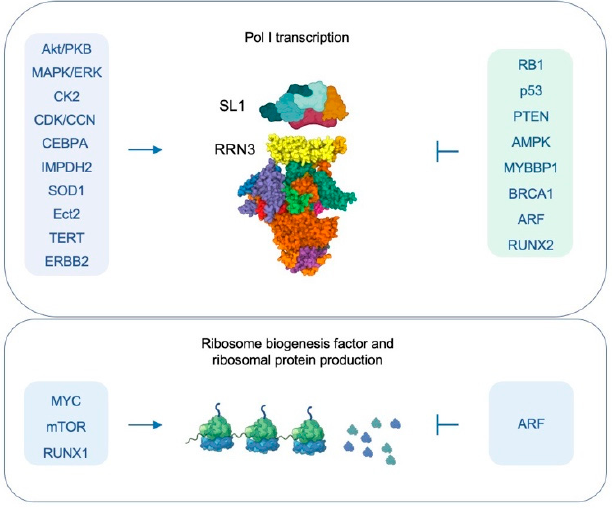
Figure 3. Major effects of positive and negative regulators of Pol I transcription and ribosome biogenesis in cancer. Human Pol I initiation complex depicted from Protein Data Bank structure, PDB:7OBA. Ref. [51].